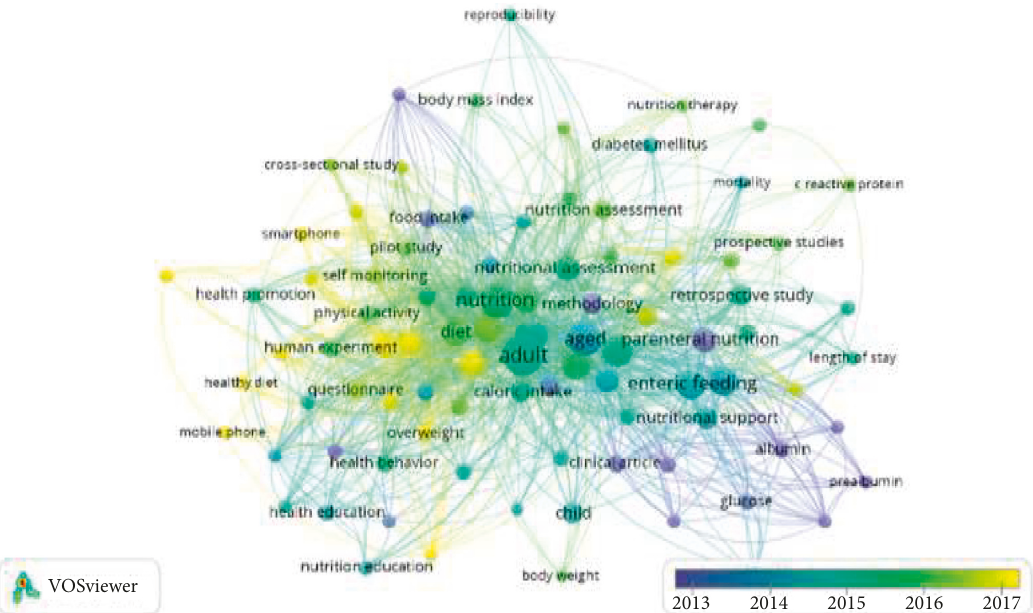
Figure 3: Overlay publication by year.